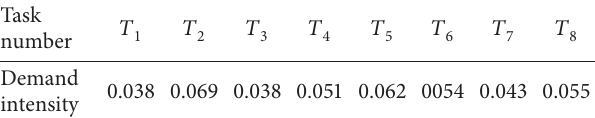
Table 7: Priority of each task. T T 1 2